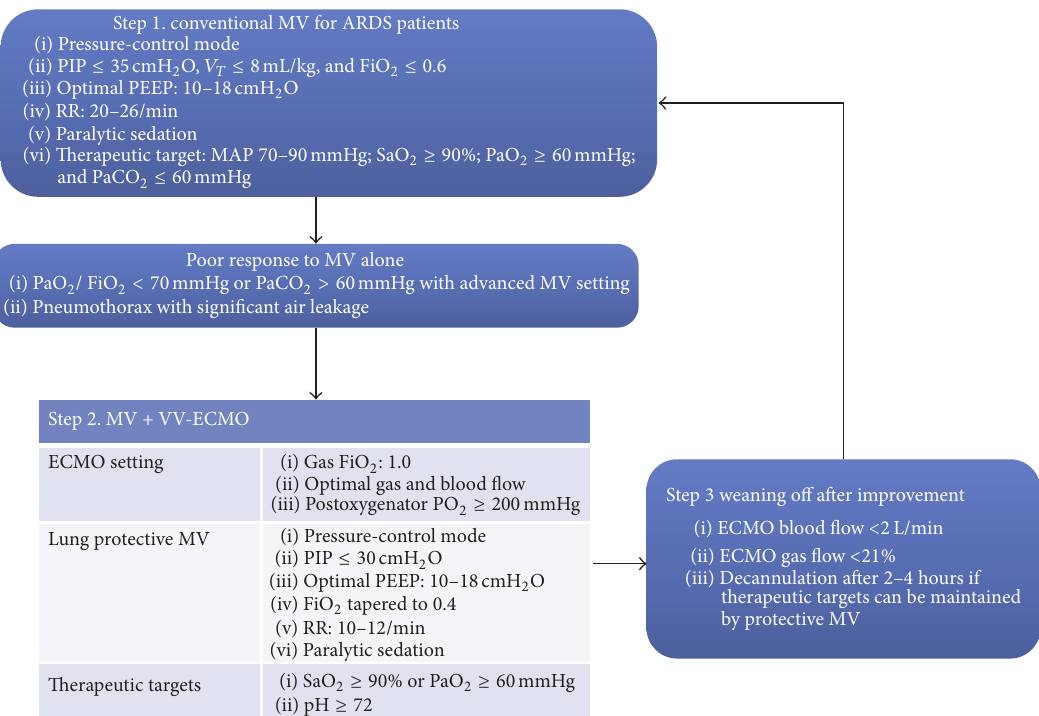
Figure 1: Management of severe acute respiratory distress syndrome in adults. Note that extracorporeal membrane oxygenation is provided after failure of conventional ventilation. Step 1 is the use of conventional MV for ARDS patients. Protective ventilation is typically employed. If the patient responds poorly to the initial MV setting, the strategy is to initiate VV-ECMO with the therapeutic target to maintain SaO 2 and serum pH. Weaning off the ECMO is considered when the blood and gas flow are decreased to 2 L/min and 21%, respectively. The figure was adapted from [9] under the Creative Commons Attribution License 4.0, which permits unrestricted use, distribution, and reproduction in any medium, provided the original work is properly cited. MV: mechanical ventilation; VV-ECMO: venovenous extracorporeal membrane oxygenation; MAP: mean arterial pressure; PEEP: positive end-expiratory pressure; RR: respiratory